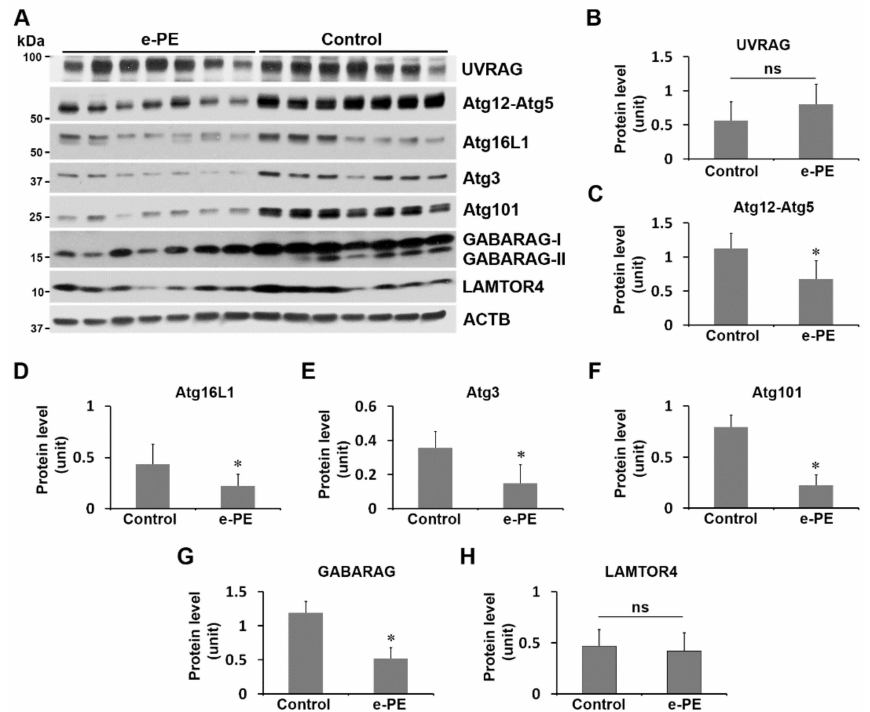
Figure 6. The abundance of key molecules of autophagic flux in the placenta from women with e-PE and gestational age-matched deliveries. ( A ) Placental tissues from e-PE and controls were assessed for protein abundance of indicated proteins using Western blotting. ( B – H ) Quantitative data for comparison of the levels of target proteins. Data are expressed as mean ± SEM and statistically analyzed by a Student’s t -test ( n = 7, *: p <